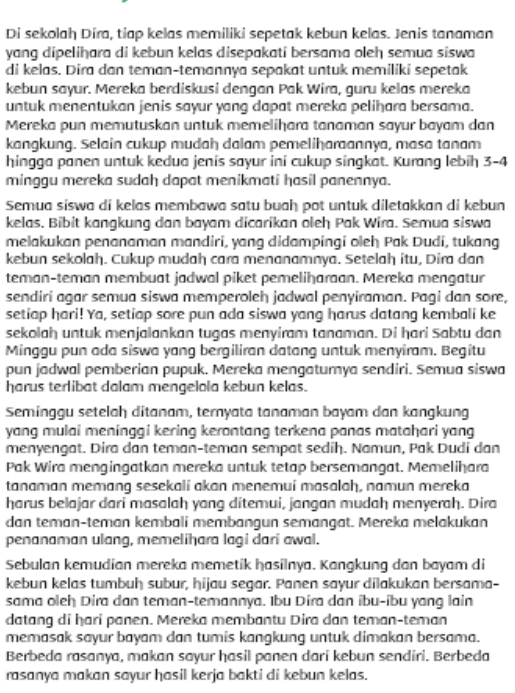
Figure 4: The sentence “Community service in the school garden”